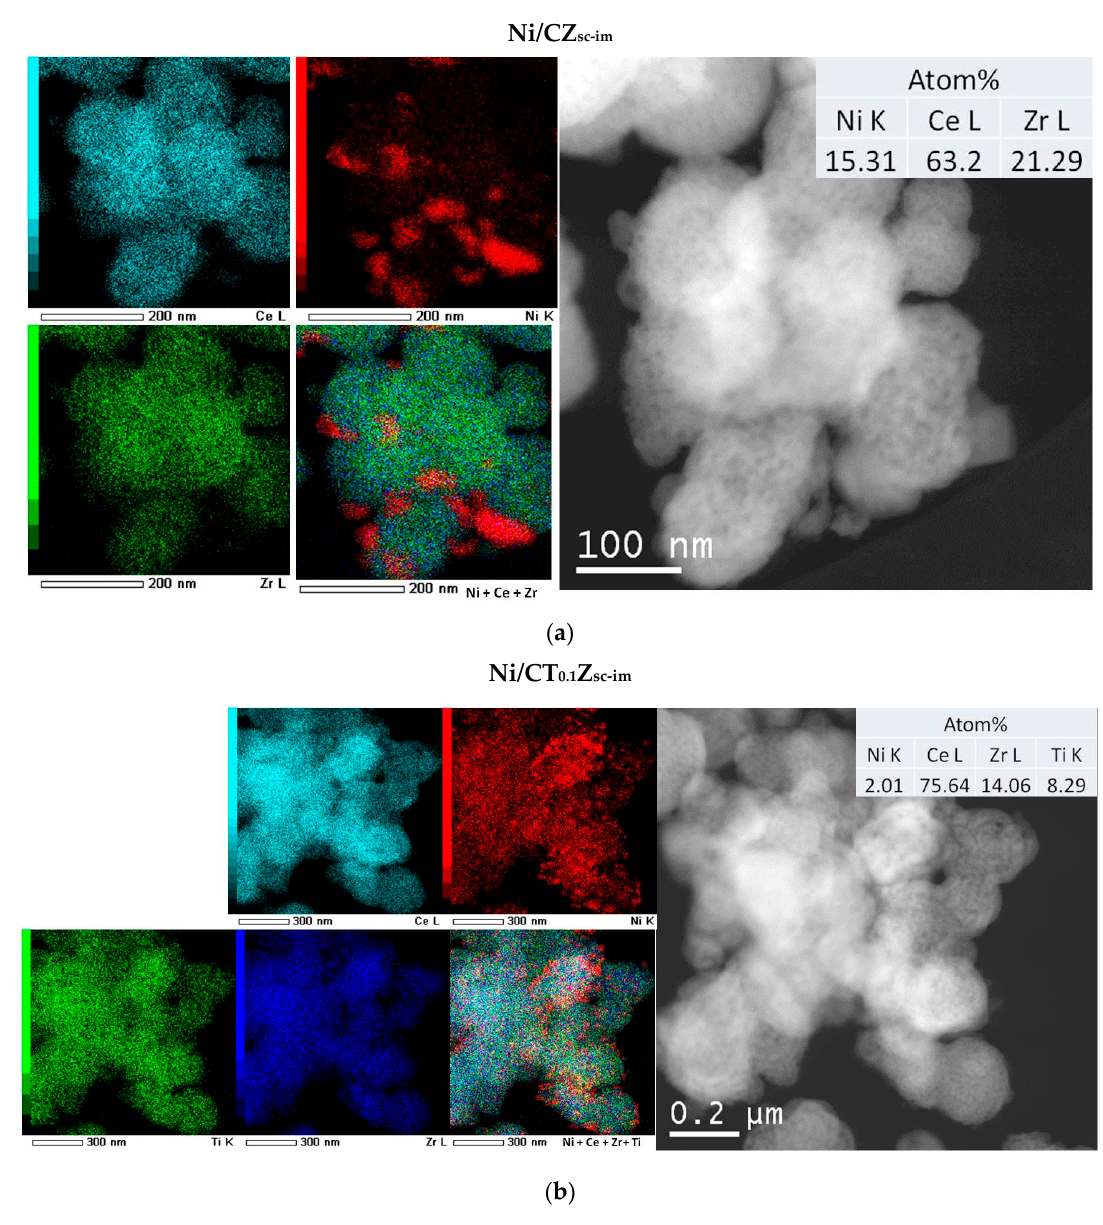
Figure 10. HAADF-STEM images with EDX analysis of the fresh impregnated 5% Ni / Ce 0.75 Zr 0.25 O 2 prepared using the Pechini route ( a ) and 5% Ni / Ce 0.75 Ti 0.1 Zr 0.15 O 2 − δ prepared using supercritical synthesis ( b